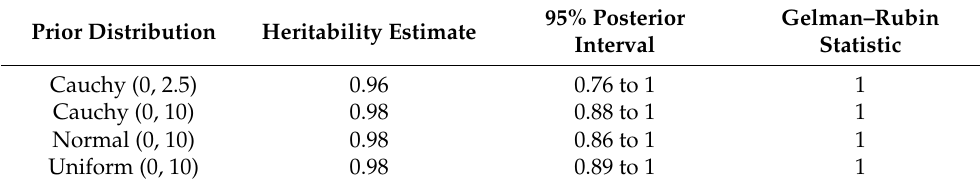
Table 3. Heritability estimates using four different prior distributions.